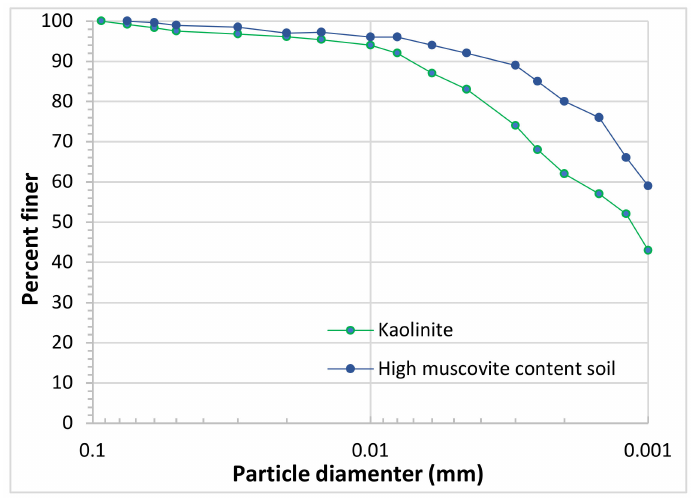
Figure 2. Grain size distribution of kaolinite and high muscovite content clayey soil. Table 1. Mineralogical composition of the two soils tested (Oriented